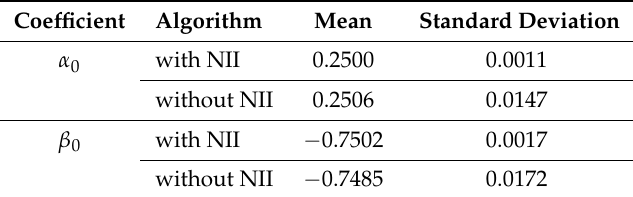
Table 1. Statistics of the attack identification